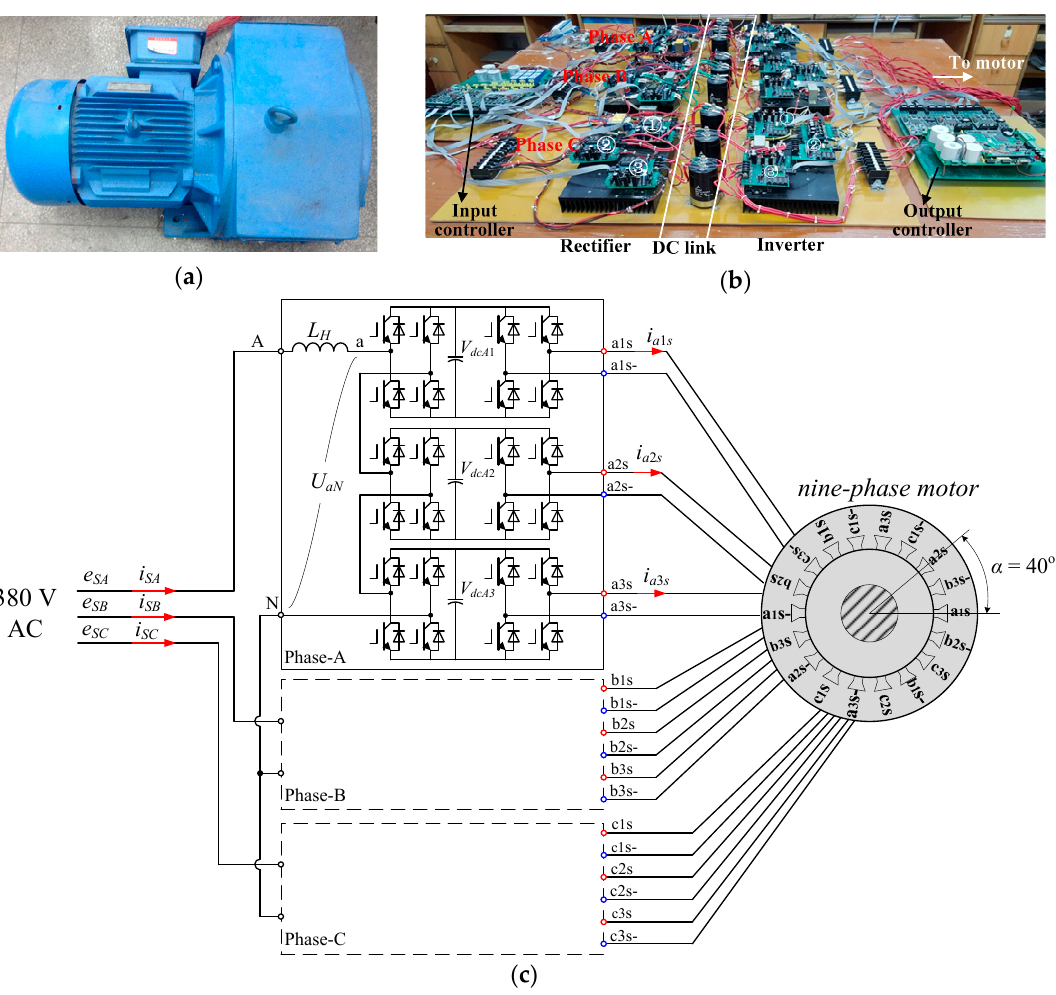
Figure 7. Experimental platform for nine ‐ phase motor. ( a ) Nine ‐ phase motor; ( b ) Prototype of the motor drive system; ( c ) Detailed test circuit. Table 3. System parameters in the prototype.